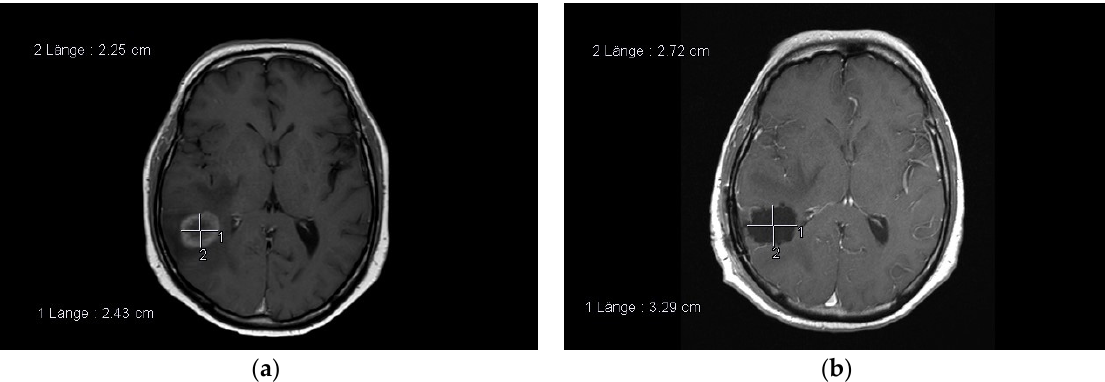
Figure 2. ( a , b ) : Examples of circumferential stripping. Adenocarcinoma metastasis in the right temporal lobe, note the resection cavity diameter exceeds the diameter of the contrast-enhanced lesion (pre- and postoperative. MRI, T1, contrast-enhanced).